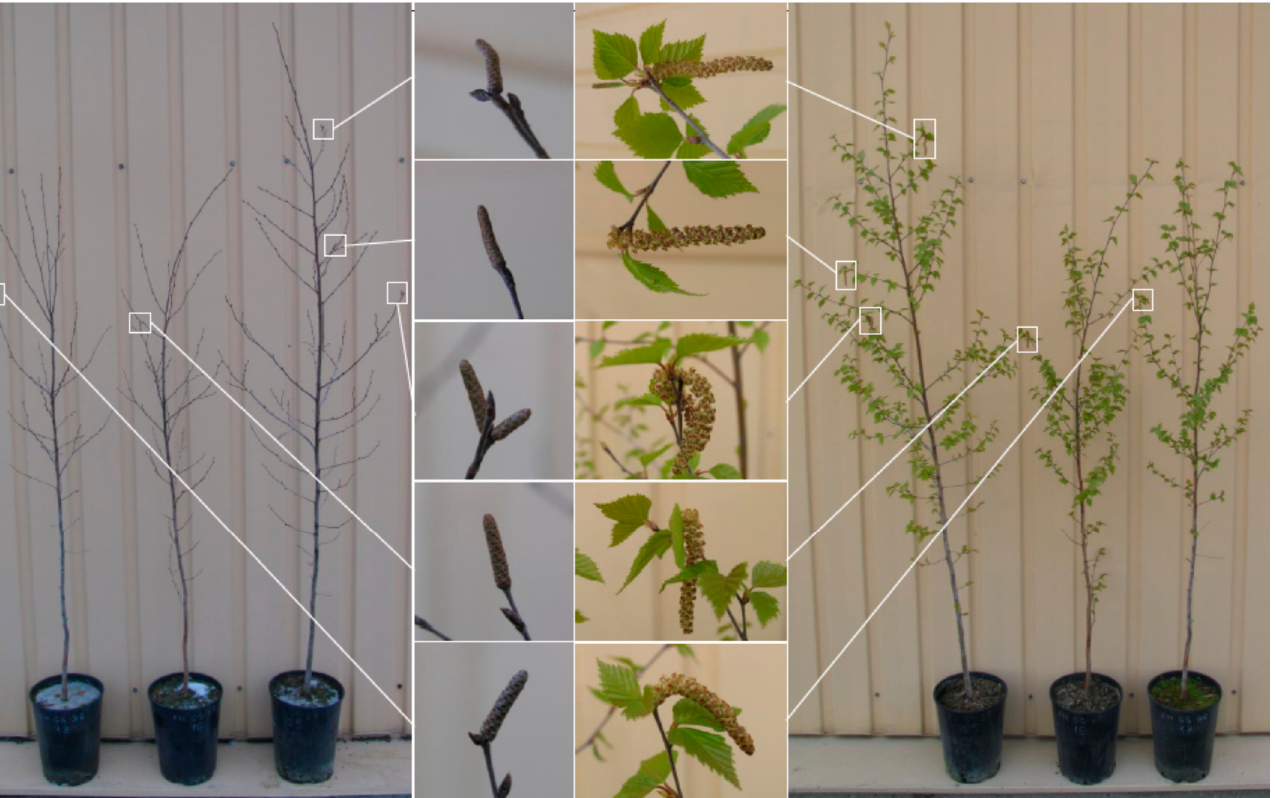
Figure 2. Accelerated flowering of transgenic birch plants with the GS1 gene (line F14 GS 8b at 0, 1 and 10 mM N supply). Left—catkins in November on three ‐ year ‐ old plants; right—flowering in May (beginning of the fourth growing season). Changes in flowering were also observed in plants overexpressing an AS gene. L.